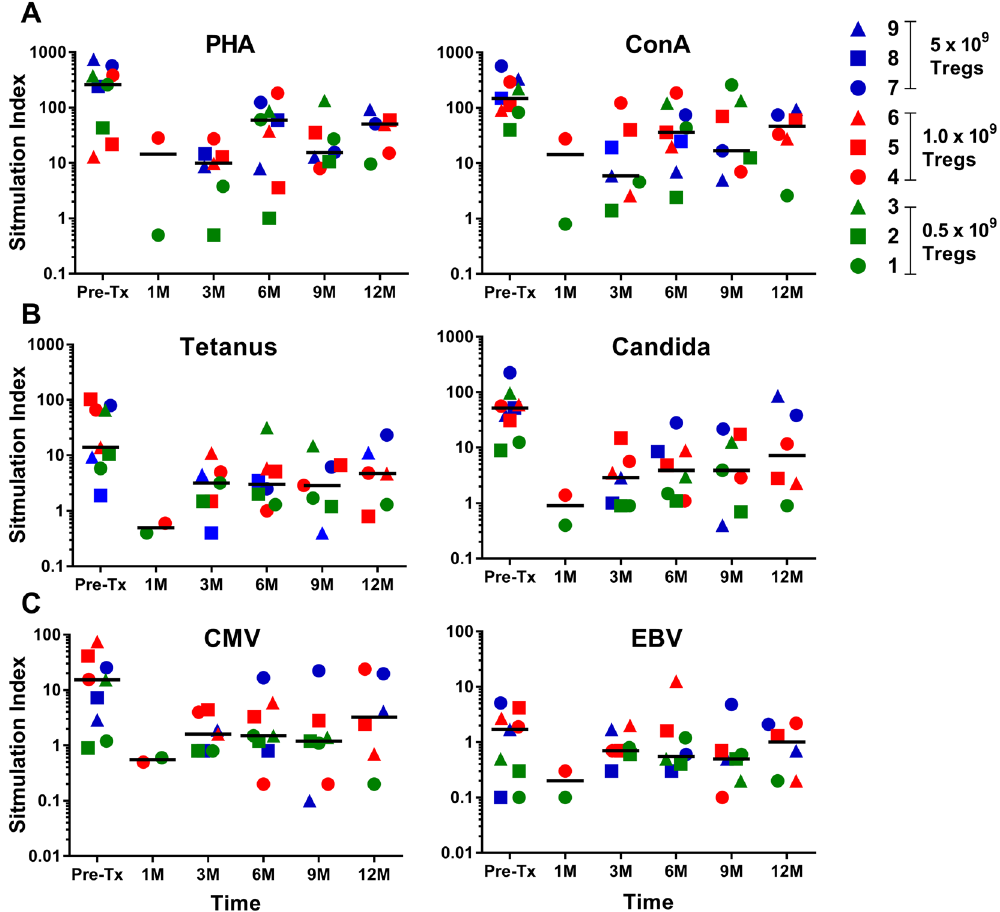
Figure 6. Recipient’s recall response to various mitogens and antigens: Stimulation indices calculated from the thymidine incorporation assays of recipient PBMCs plus antigen versus recipient PBMCs plus media only. Individual patient responses are displayed as symbols (n = 9) and the grand median as –line at indicated time points post-transplant. Pre-Tx = pre-transplant.